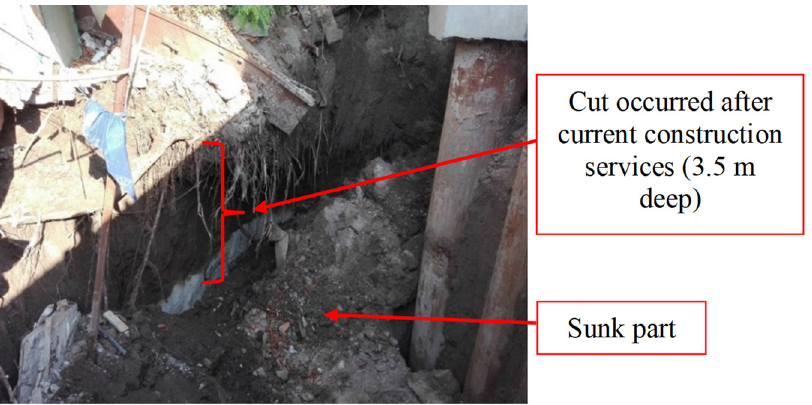
Figure 1. Local shears and subsidence of daylight surfaces near the St. Andrew’s